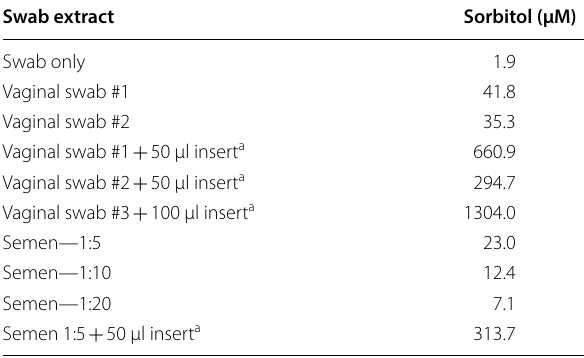
Table 3 Measuring sorbitol as a marker for presence of vaginal insert